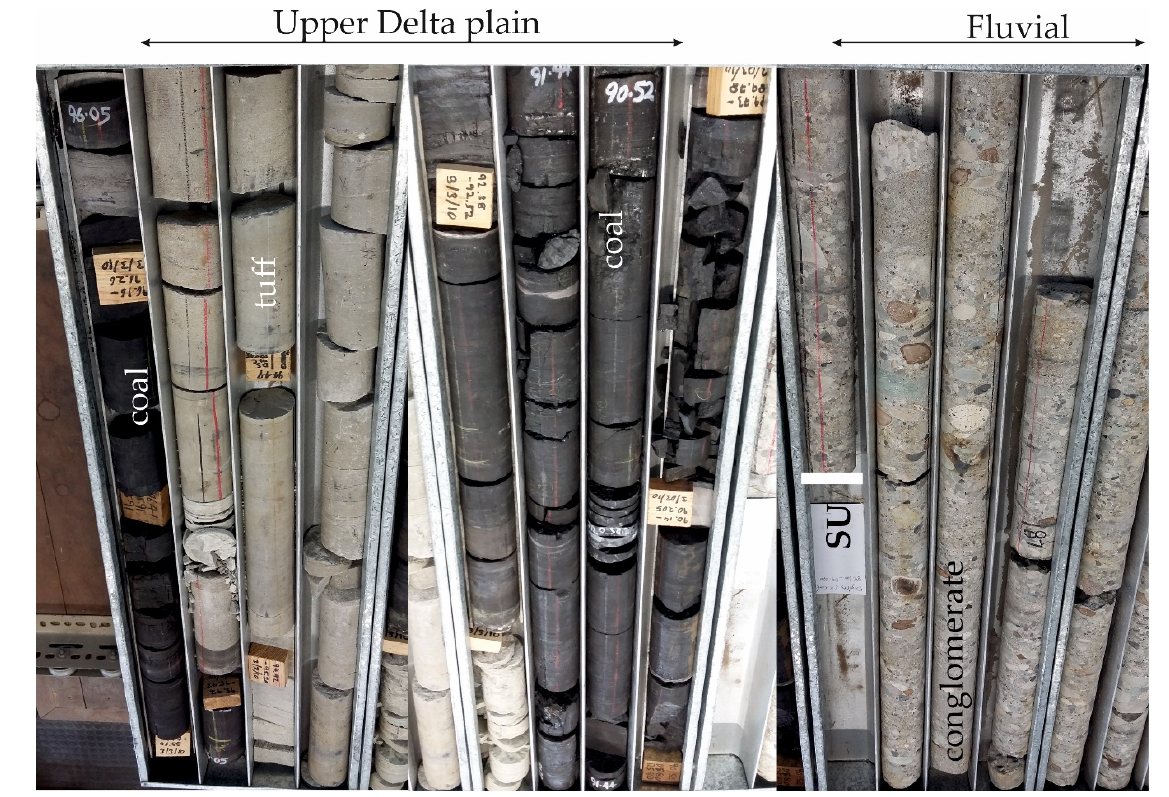
Figure 10. Core photographs illustrating the shift from upper delta-plain to fluvial deposits. Note the abrupt increase in sediment grain-size, from fine-grained, coaly sediments (floodplains of the upper delta-plain) and tuffs to conglomeratic fluvial deposits. The boundary between the two depositional environments corresponds to the subaerial unconformity (SU), which is formed during forced regression and marks the change from highstand to lowstand normal regression.